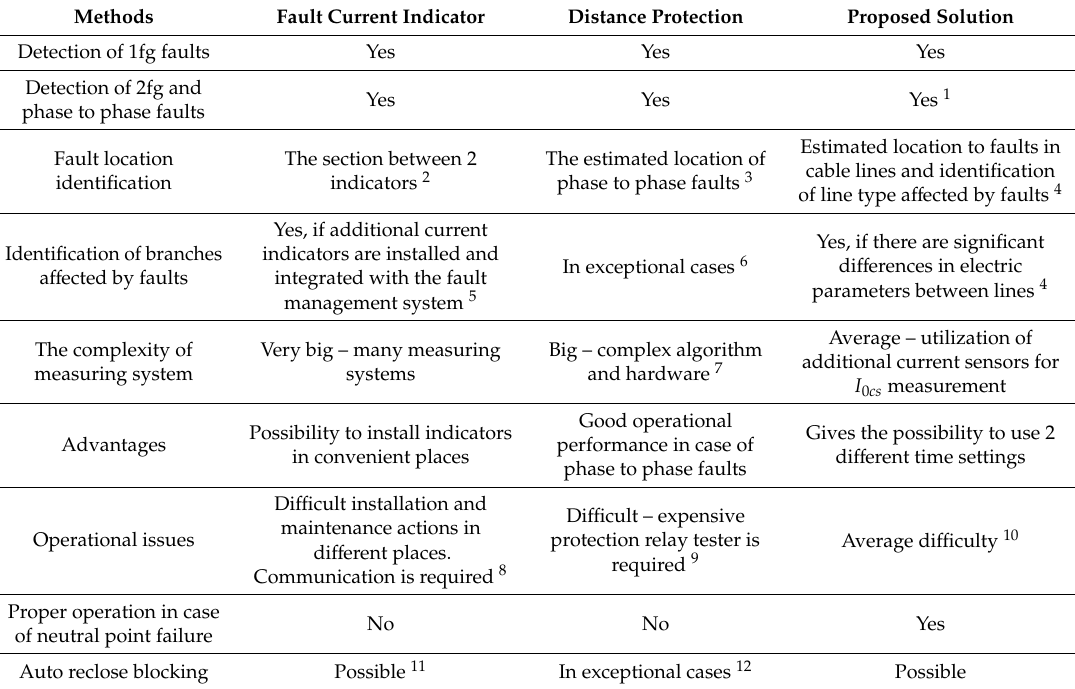
Table 1. Comparison of earth fault location methods in MV